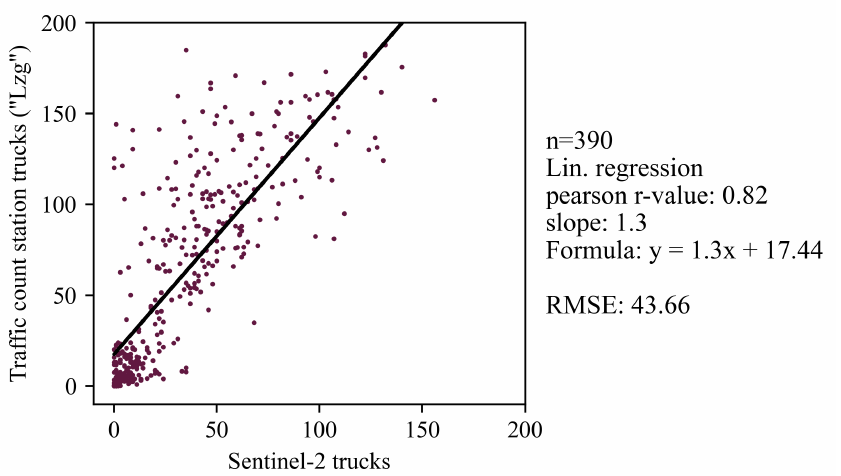
Figure 11. Comparison of Sentinel-2 truck counts with traffic count station truck (“Lzg”) counts. Table 3. Statistical summary of station and Sentinel-2 counts. Standard Deviation Max. Count